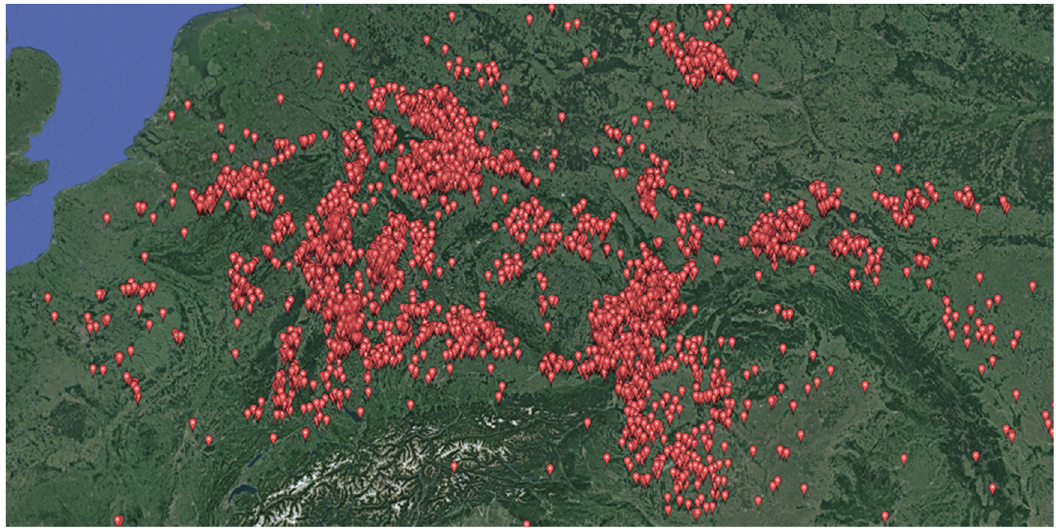
Figure 4: Distribution of Linear Pottery Culture settlement fi ndings; created with the “ Google Mapper ” function of the Montelius database ( Stadler, 2019, p. 431, Figure 22.2 )